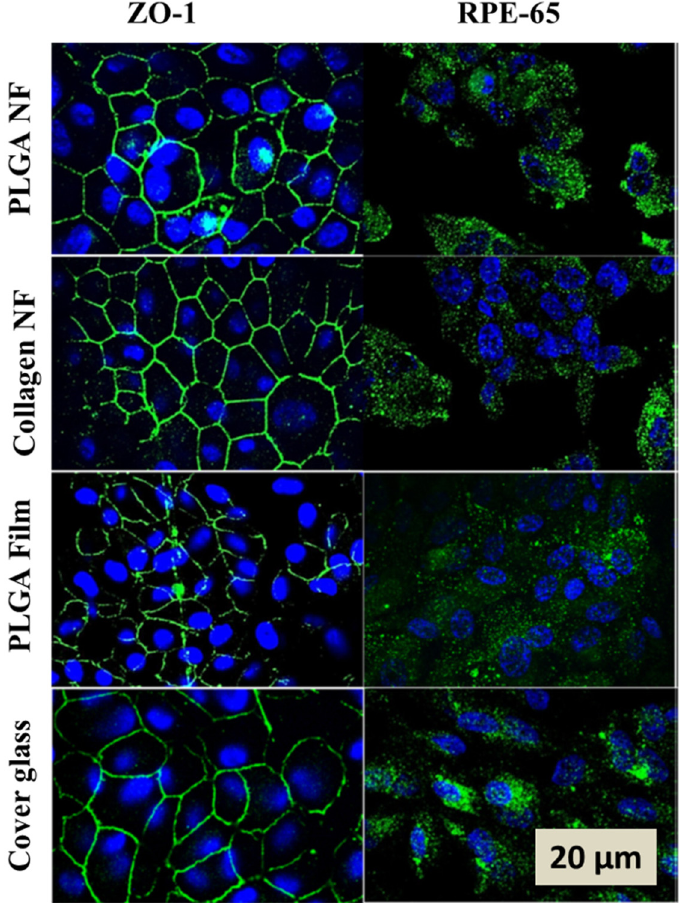
Figure 3. Immunofluorescence image of the expression of ZO-1 and RPE65 antibodies by human RPE cells on PLGA and collagen nanofibrous membranes. Reprinted from